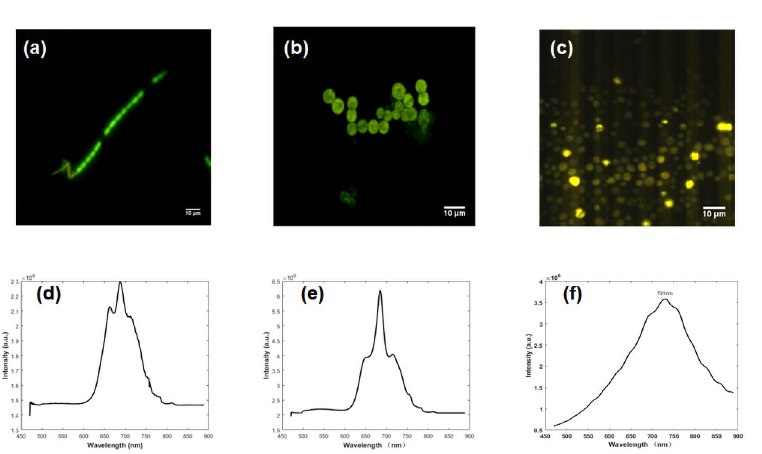
Fig 3. Hyperspectral fluorescence images and extraction spectrum. (a) Precolor overlay image of Anabaena flosahuas. (b) Precolor image of Microcytic aeruginosa (c) Color overlay image of Chlorella sp. (d) Mean spectrum of Anabaena flosahuas (e) Mean spectrum of Microcytic aeruginosa. (f) Mean spectrum of Chlorella sp.